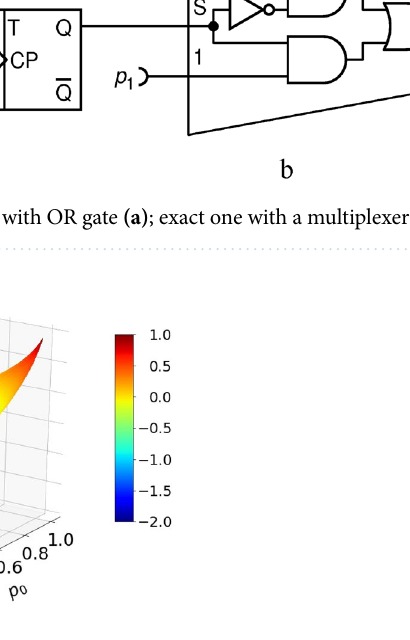
Figure 7. Entropy budget of a summation circuit with inputs p 0 and p 1 that would output p z = ( p 0 + p 1 )/ 2 . Plot shows the function